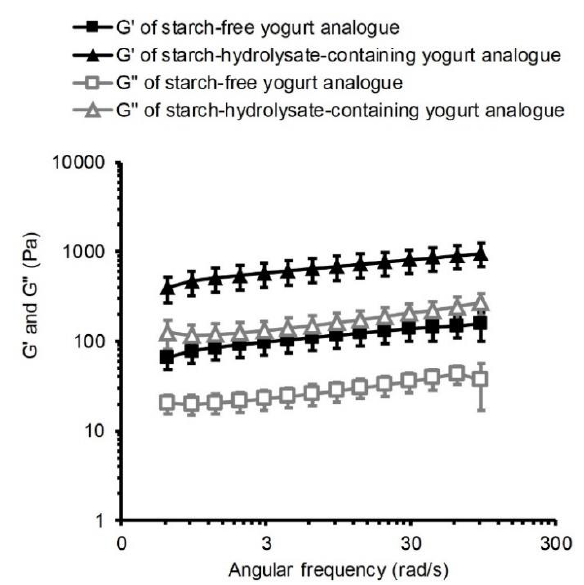
Figure 2. Viscoelasticity (storage modulus, G’, and loss modulus, G’’) of faba bean starch-free and starch-hydrolysate-containing yogurt analogues measured by frequency-sweep oscillation. Each point represents the average value of triplicate measurements with standard deviations.